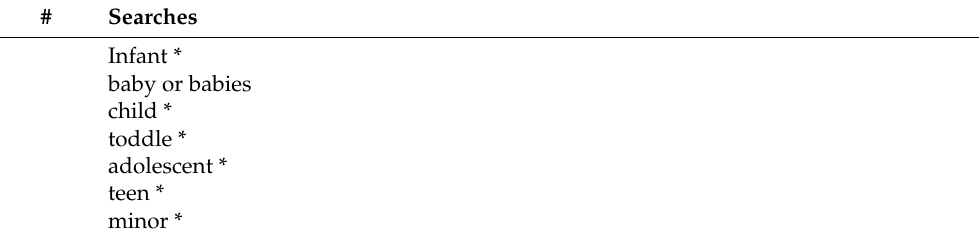
Table A6. Search